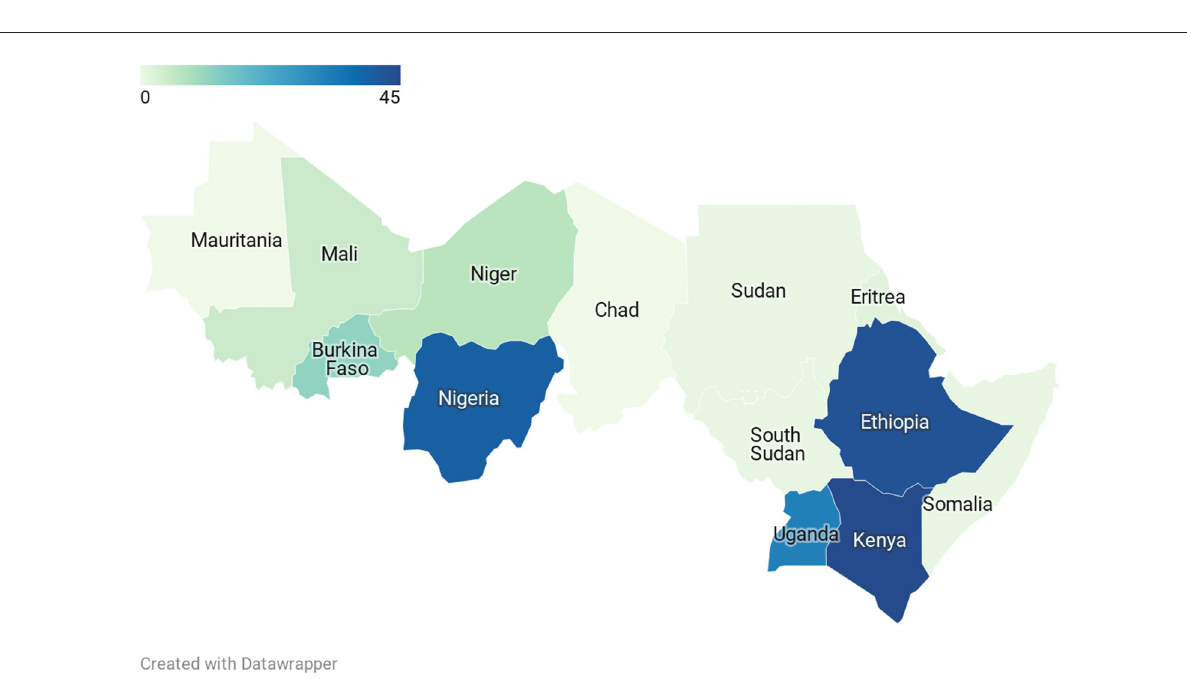
qualitative), or tracing how gender roles evolve over time through qualitative